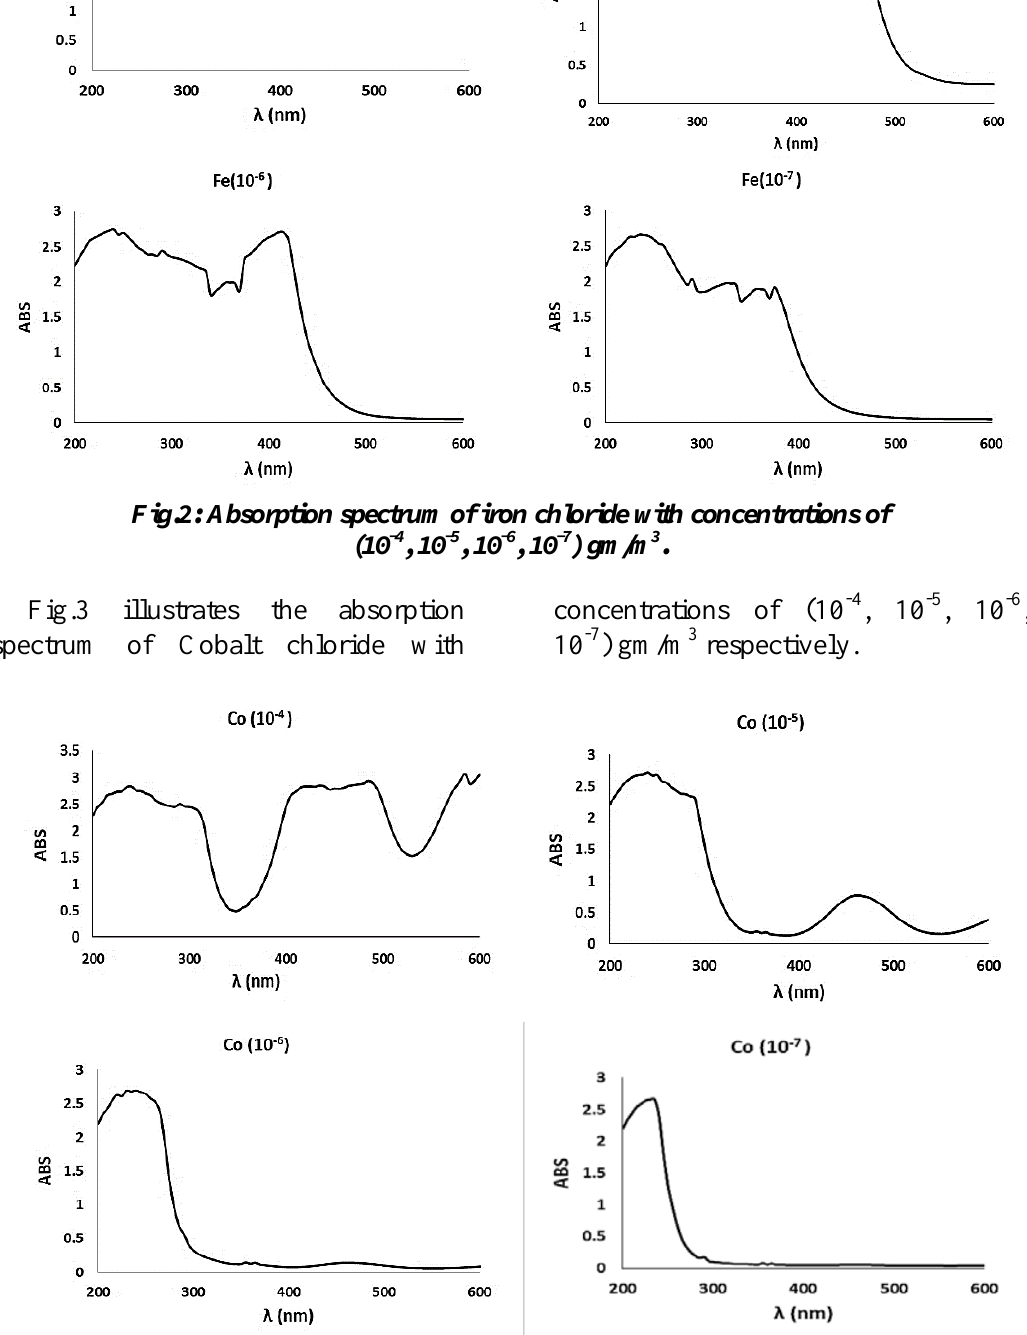
Fig.3: Absorption spectrum of Cobalt chloride with concentrations of (10 -4 , 10 -5 , 10 -6 , 10 -7 ) gm/m 3